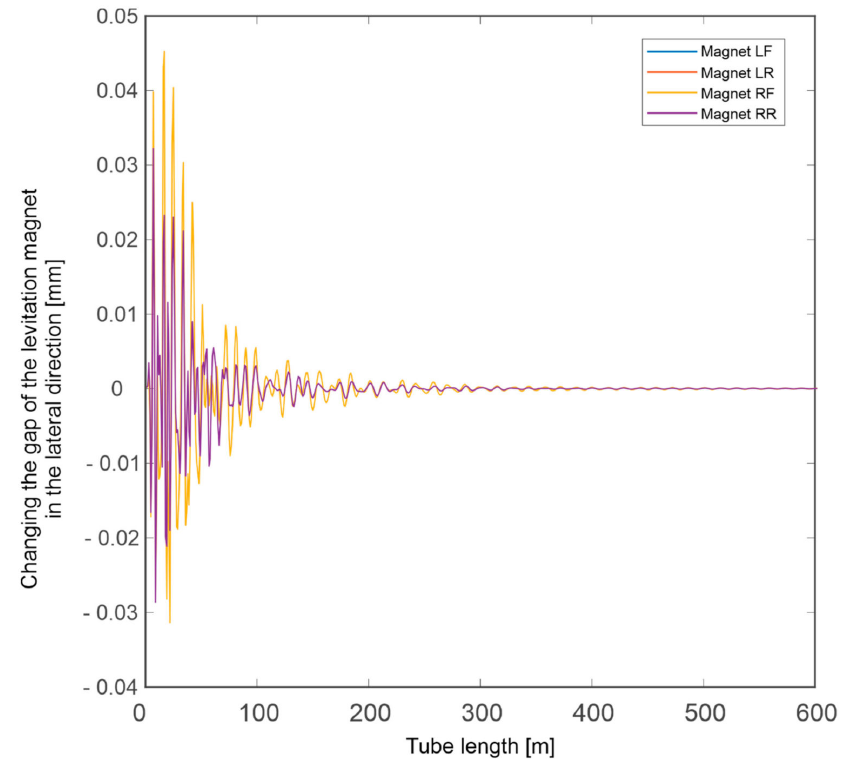
Figure 6. Change in the gap width on the levitation magnet in the lateral direction resulting from the capsule speed of 1000 km / h.